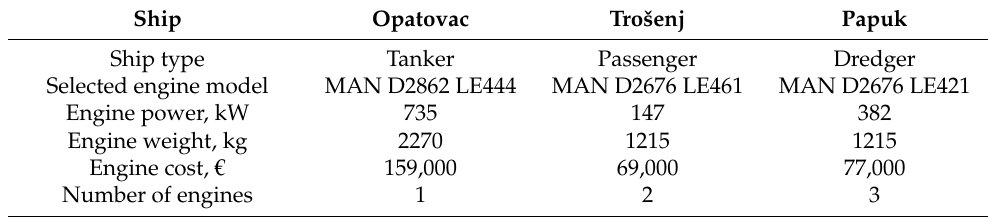
Table 3. Engines selected for